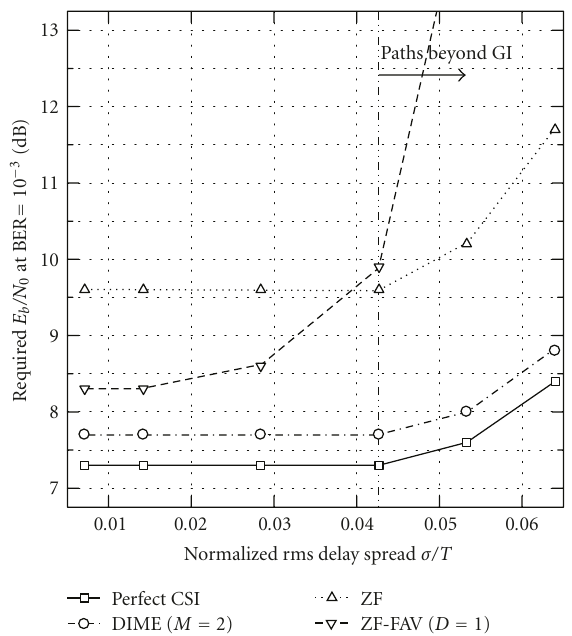
Figure 9: Required E b /N 0 performance versus normalized rms delay spread with f d T = 0 . 0075 (64-QAM-OFDM).